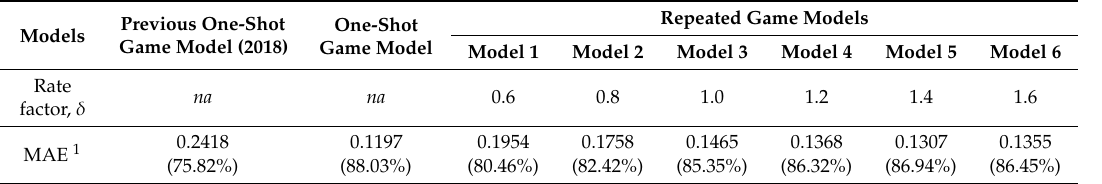
Table 4. Validation